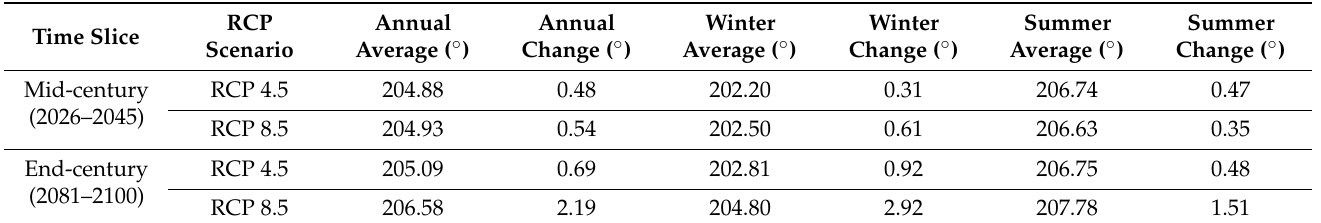
Table 9. Mid and end-century average extreme Dm and change relative to the past.